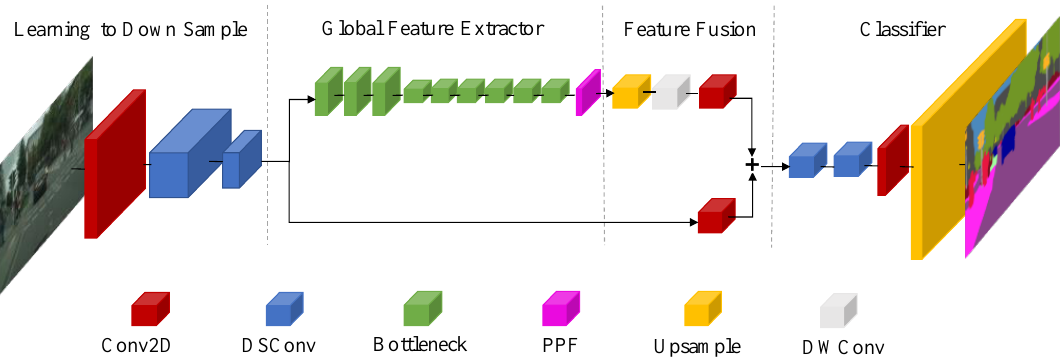
Figure 2. The Fast-SCNN network architecture consists of four parts: learning down sample, global feature extraction, feature fusion, and classifier. The network performs real-time semantic segmenta- tion on the target in the camera frame and determines its dynamic and static attributes according to the category to which the pixel belongs.